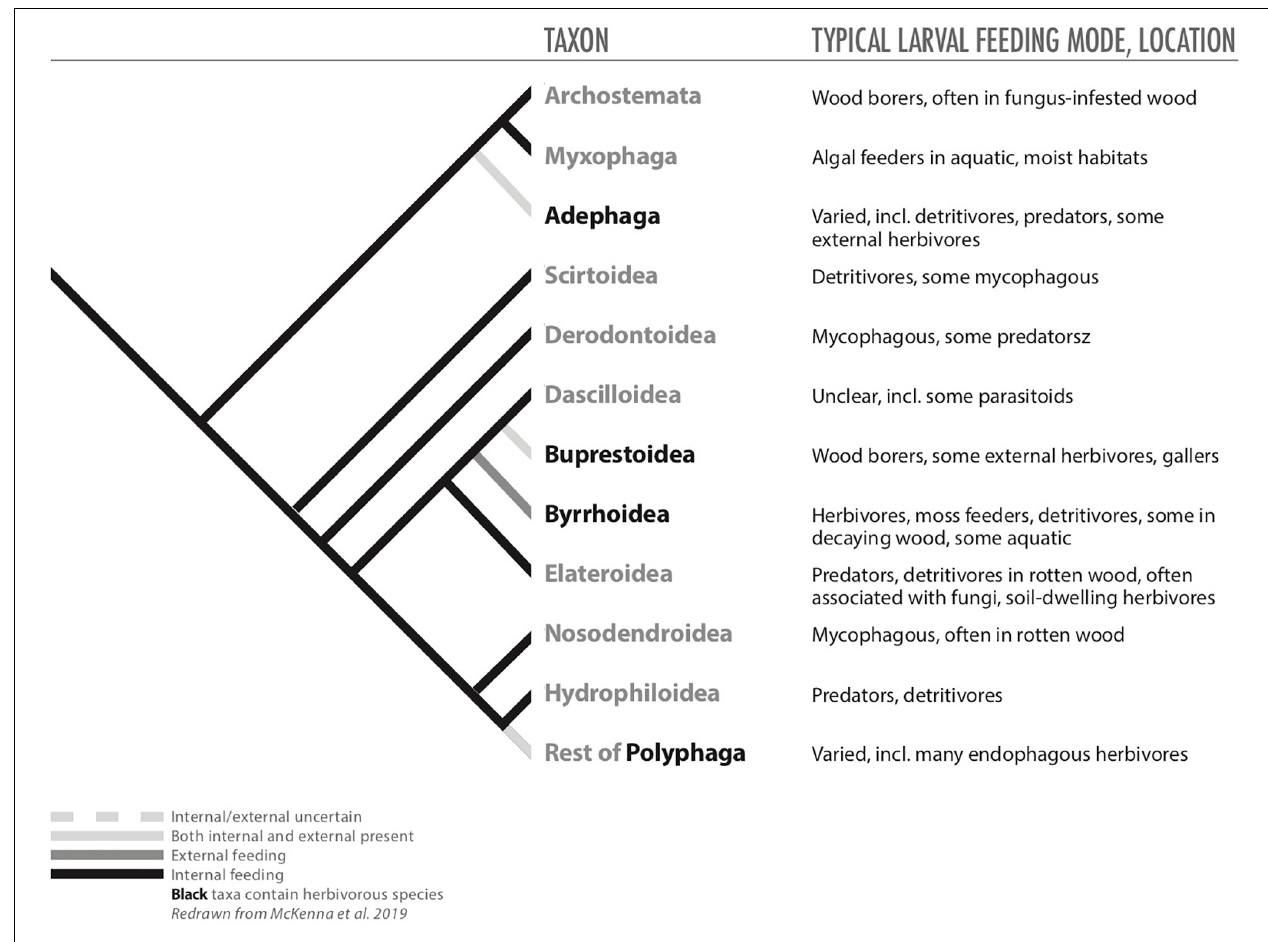
FIGURE 3 | Phylogeny of basal Coleoptera (from McKenna et al., 2019) redrawn to illustrate hypothesized distributions of internal and external feeding among